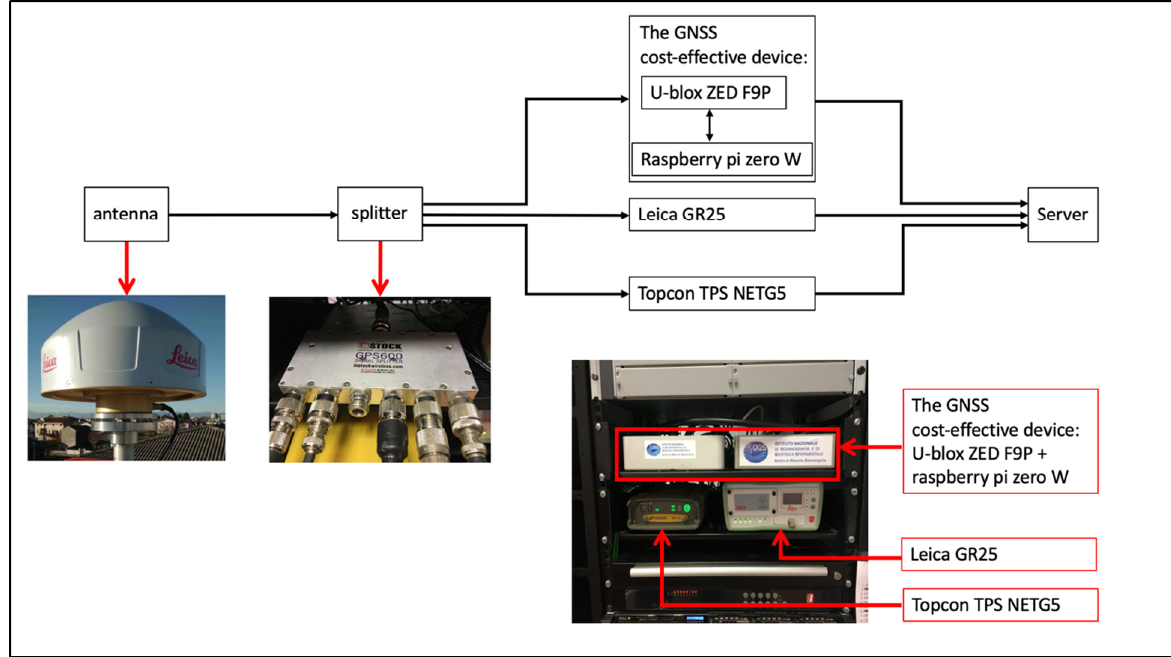
Figure 1. Block diagram of the sensors system. The GNSS cost-effective device is detailed in Figure 2.